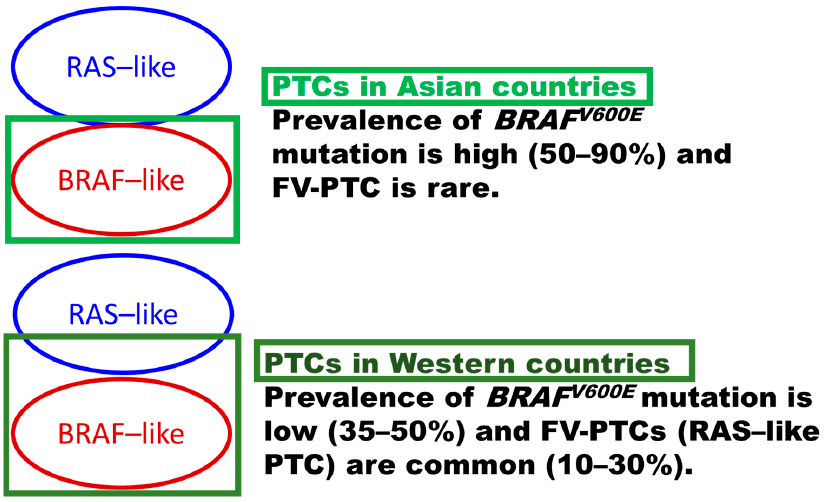
Figure 2. The green square (upper field) indicates the definition of Asian papillary thyroid carcinoma (PTC), which covers all BRAF -like PTCs but rare RAS -like PTCs. It shows why the prevalence of BRAFV600E is high (50–90%), and RAS -like follicular variant PTC (FV-PTC) is rare in the Asian definition of PTC. The lower dark green square shows the Western definition of PTC, which covers both BRAF -like PTC with fully developed PTC-type nuclear features and RAS -like PTC with delicate nuclear features.